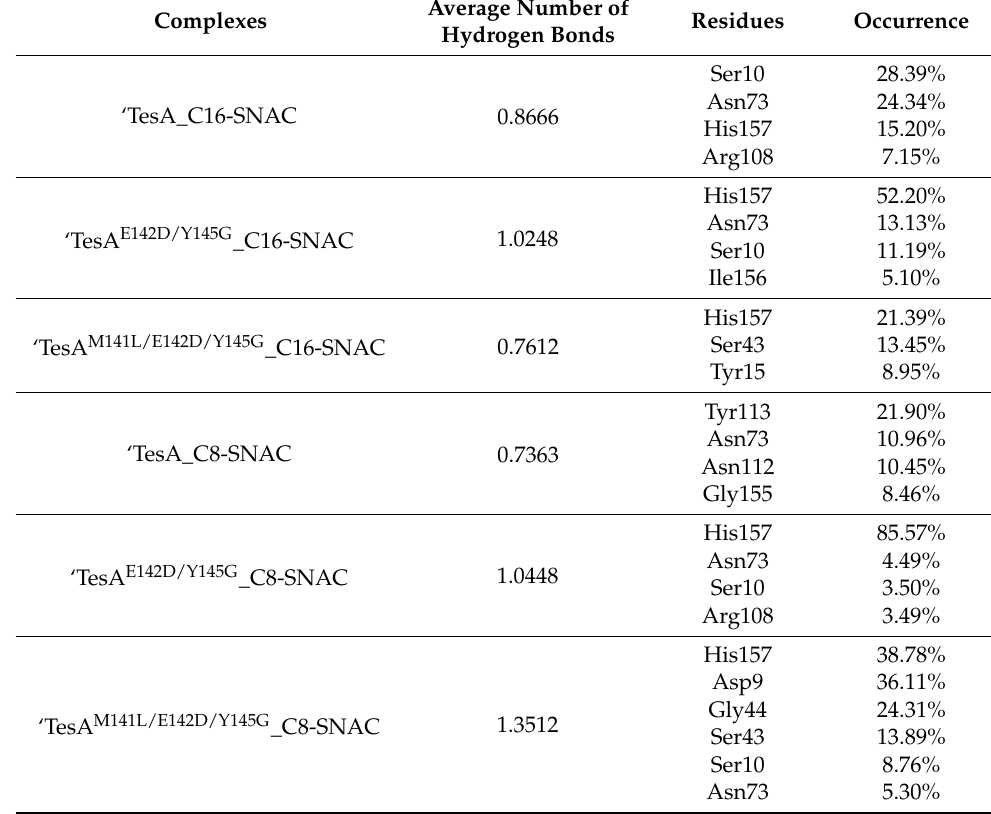
Table 1. The average number of hydrogen bonds in each frame conformation and hydrogen bond occu- pancy rates between substrates and different residues in the six complexes during the MD